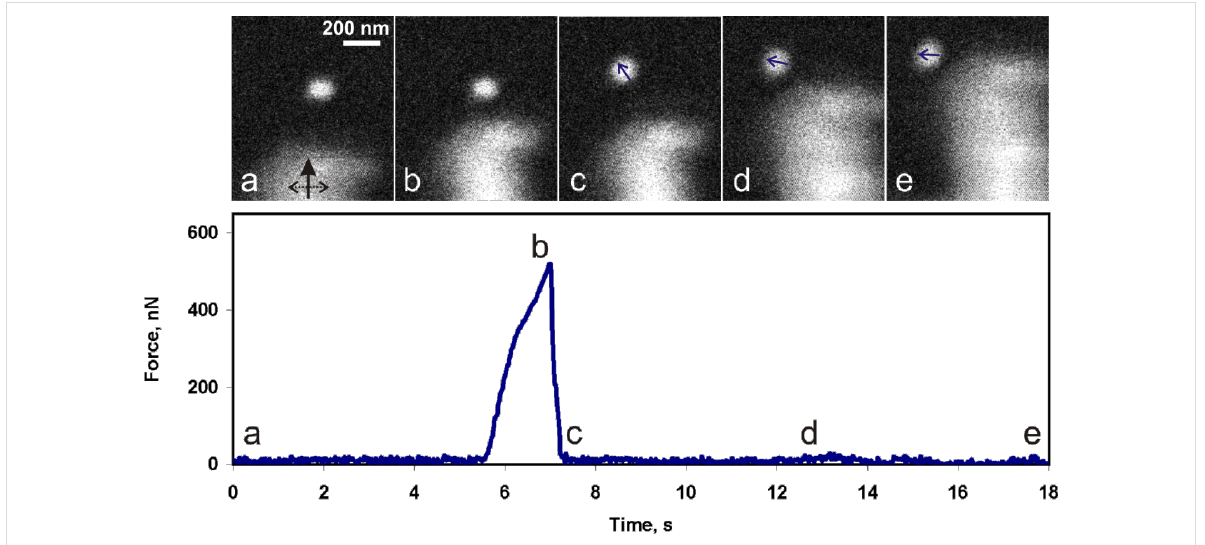
Figure 5: SEM snapshots of the manipulation process of a Au NP by using a tungsten tip, and the corresponding force curve. The black solid arrow in image (a) indicates the movement direction of the tip and dashed arrow shows tip the oscillation direction. The small blue arrows indicate the NP dis- placement directions (b, c, d).